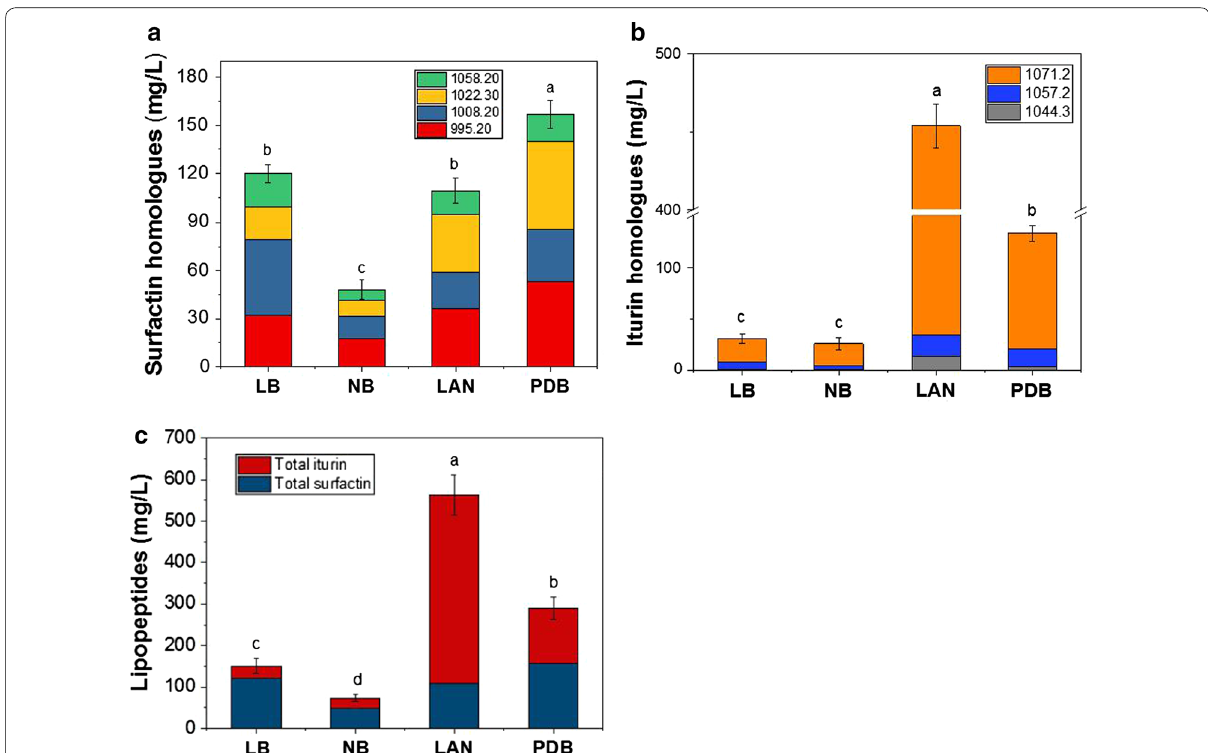
Fig. 1 Effect of different culture media on the production of surfactin homologues ( a ), iturin homologues ( b ) and lipopeptides ( c ). Values are expressed as mean SD, n 4. The different letters indicate significant differences between treatments (p < 0.05). LB lysogeny broth, NB nutrient ± = broth, LAN Landy medium, PDB potato-dextrose